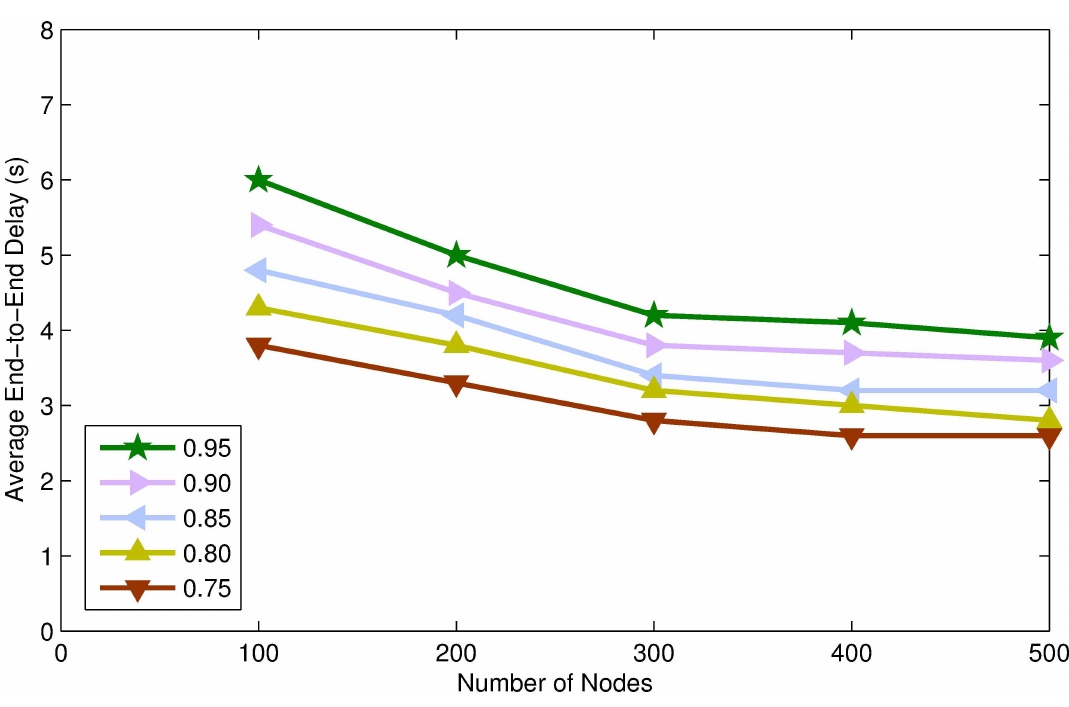
Fig 7. Average end-to-end delay vs. node density.